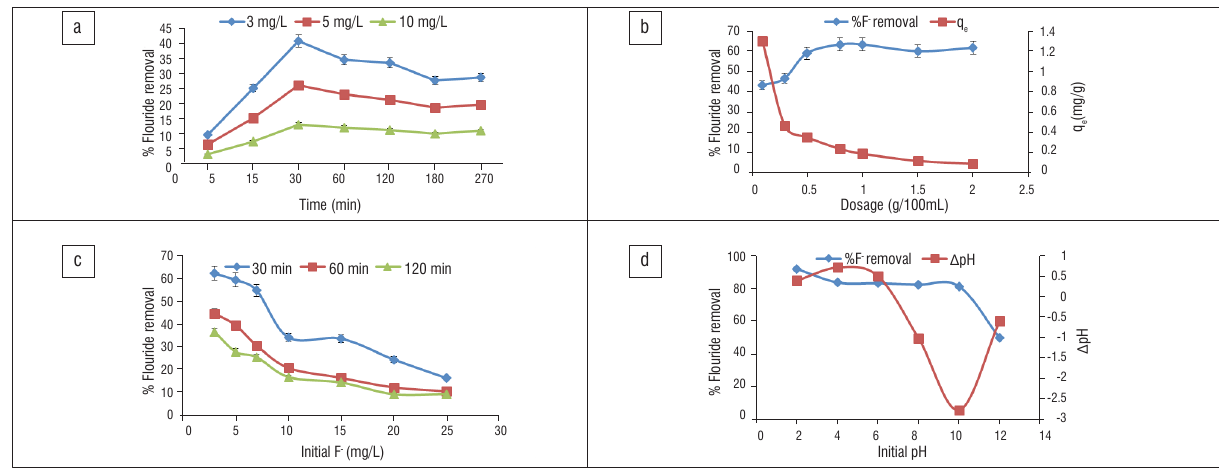
Figure 4: Optimisation of fluoride removal by smectite-rich clay soil: (a) effect of contact time, (b) effect of adsorbent dosage, (c) effect of initial concentration and (d) effect of initial